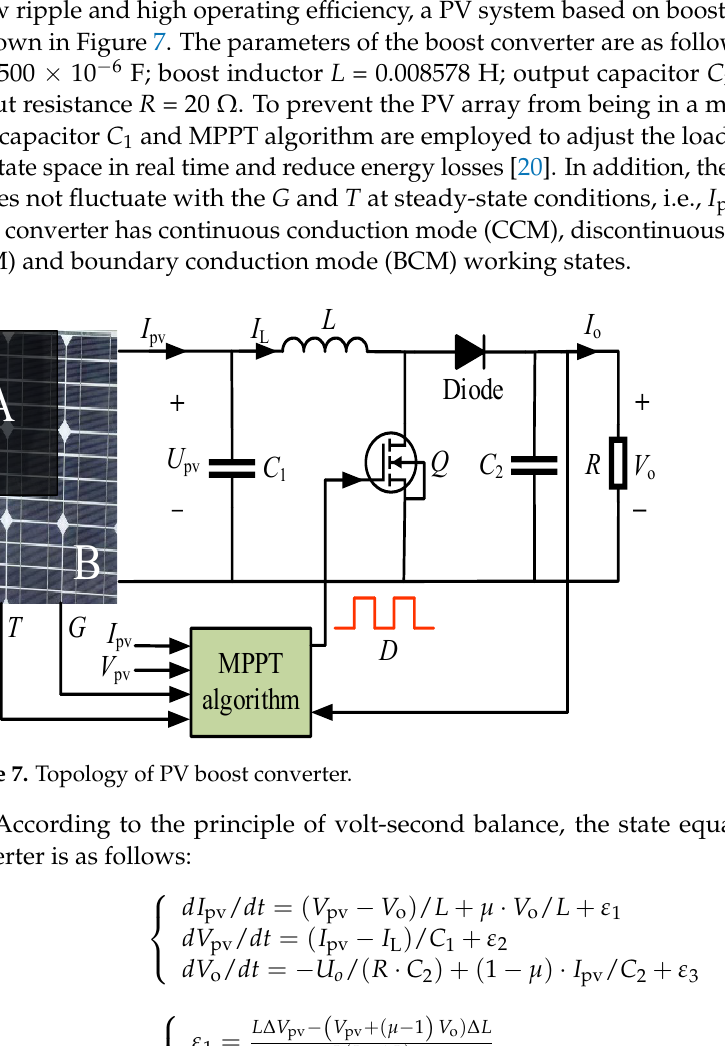
Figure 6. PV characteristic curve under PSC.